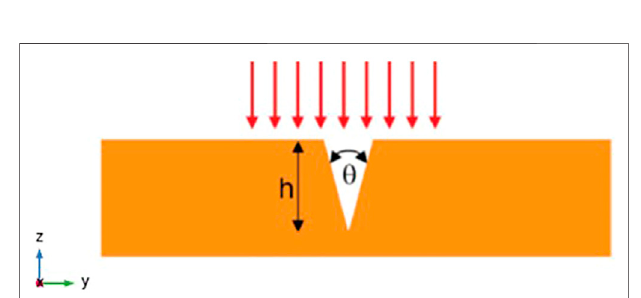
FIGURE 8 | Sketch of the V-shape plasmonic structure, illuminated by a TM-polarized light. Complete with permission of Søndergaard et al. (2010). Copyright 2010 American Chemical